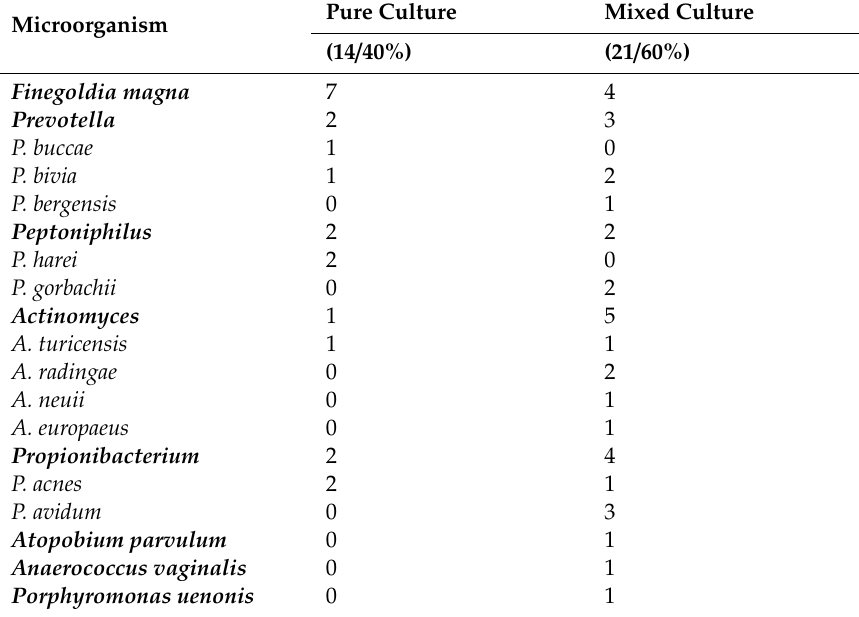
Table 2. Anaerobic microorganisms isolated from breast abscesses. Pure Culture Mixed Culture Microorganism (14 / 40%) (21 /